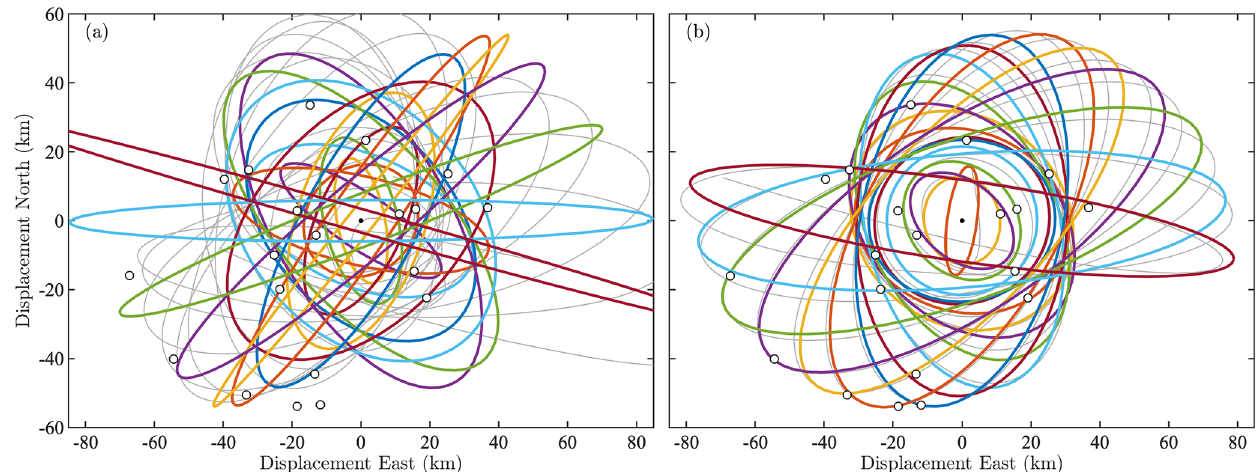
Figure 6. Ellipses inferred from the composite signal in Fig. 5a using (a) the analytic signal method directly or (b) the wavelet ridge method of Sect. 3. The gray line in each panel is the estimated modulated elliptical signal using that method, while the dots are as in Fig.